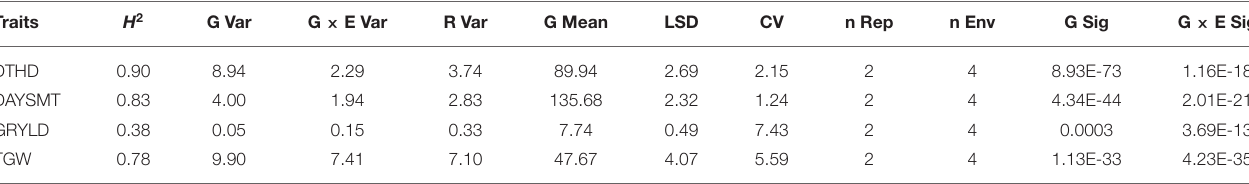
TABLE 2 | Variability analysis of various yield-related agronomic traits for four environments at two locations. Traits H 2 G